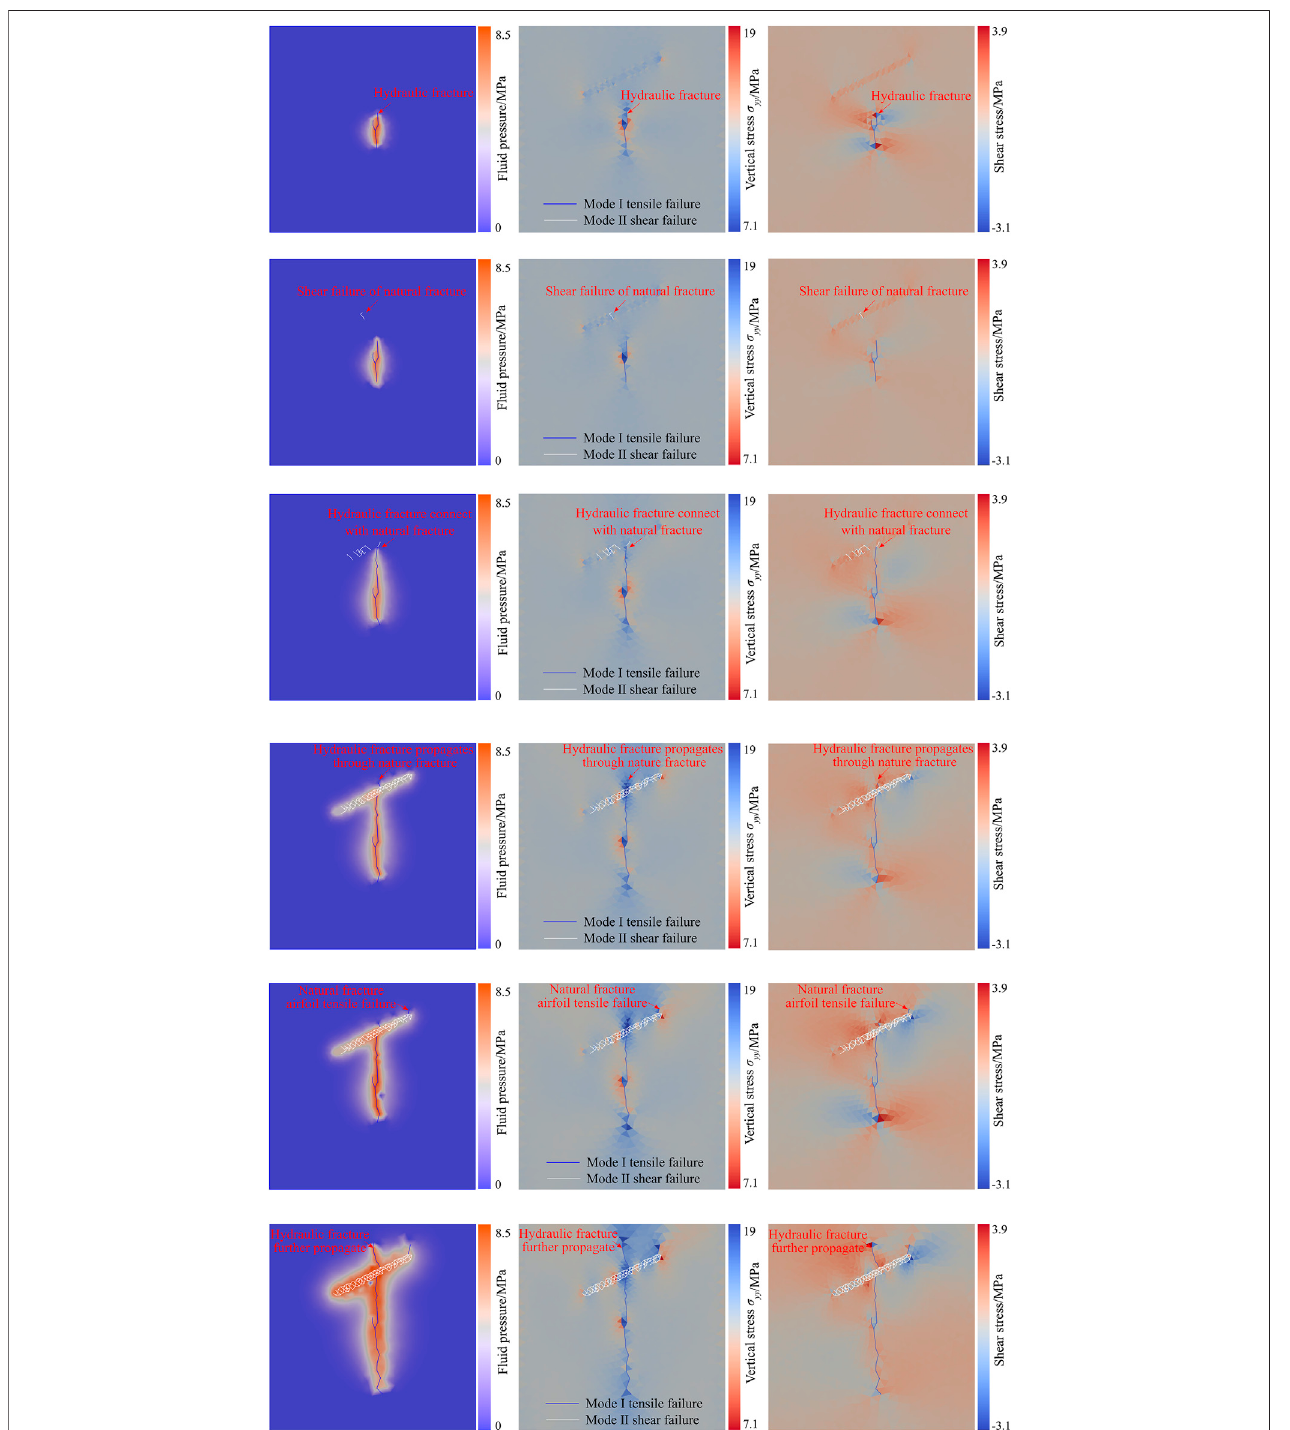
FIGURE 7 | The distribution of fl uid pressure, vertical stress, and shearing stress during hydraulic fractures propagation. (A) t (cid:2) 0.387 s; (B) t (cid:2) 0.430 s; (C) t (cid:2) 0.882 s; (D) t (cid:2) 1.462 s; (E) t (cid:2) 1.634 s; (F) t (cid:2) 3.354 s.